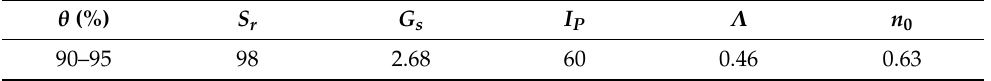
Table 2. Physical parameters of soft Bangkok clay obtained from Abuel-Naga et al.